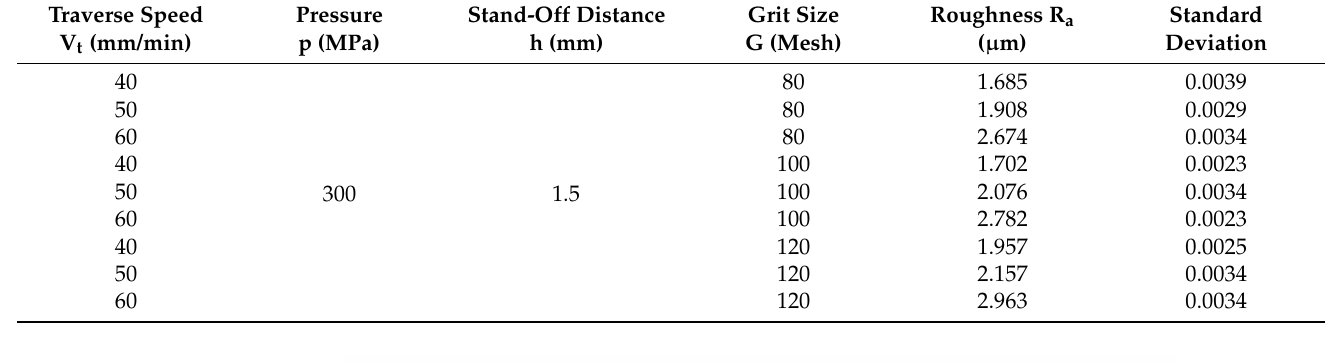
Table 4. Roughness values obtained upon adjusting traverse speed and grit size.